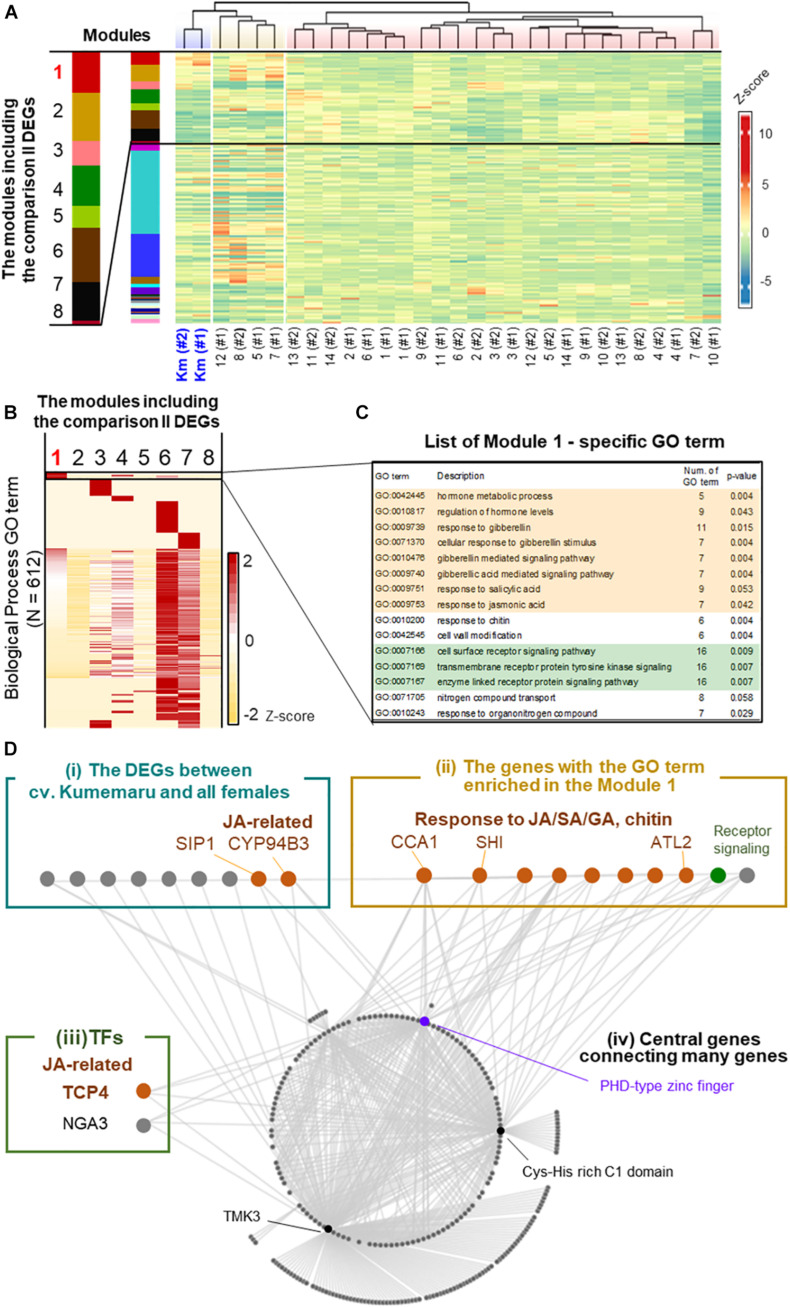
Co-expression network analysis in cv. Kumemaru and the predominantly female-producing cultivars. (A) Co-expression moduling of the genes based on expression patterns in cv. Kumemaru and 14 predominantly female-producing cultivars, with the WGCNA package. Modules 1–8 included the comparison II DEGs. (B) Heatmap for the enrichment of GO terms involving biological processes in these eight modules. The numbers of annotated GO terms were standardized by Z-scoring. (C) List of the GO terms specifically enriched in module 1 (p < 0.06), which included most of the cv. Kumemaru-specific DEGs. The GO terms relating to the hormonal process and receptor signaling pathway were highlighted in orange and green, respectively. (D) Visualization of the coexpressed gene network in module 1. As described in the main text, they were categorized into the following four groups: (i) the DEGs specific to cv. Kumemaru, (ii) the genes with the GO terms specifically enriched in module 1, as given in the panel (C), (iii) transcription factors, and (iv) central genes in this network.